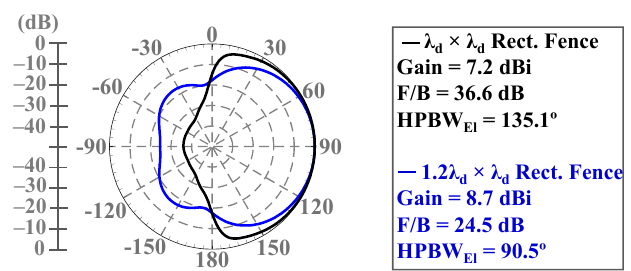
Figure 2. The radiation pattern of the rectangular fenced dipole with X FENCE × Y FENCE = λ d × λ d and 1.2 λ d × λ d . Table 1. Electric dipole design parameters.